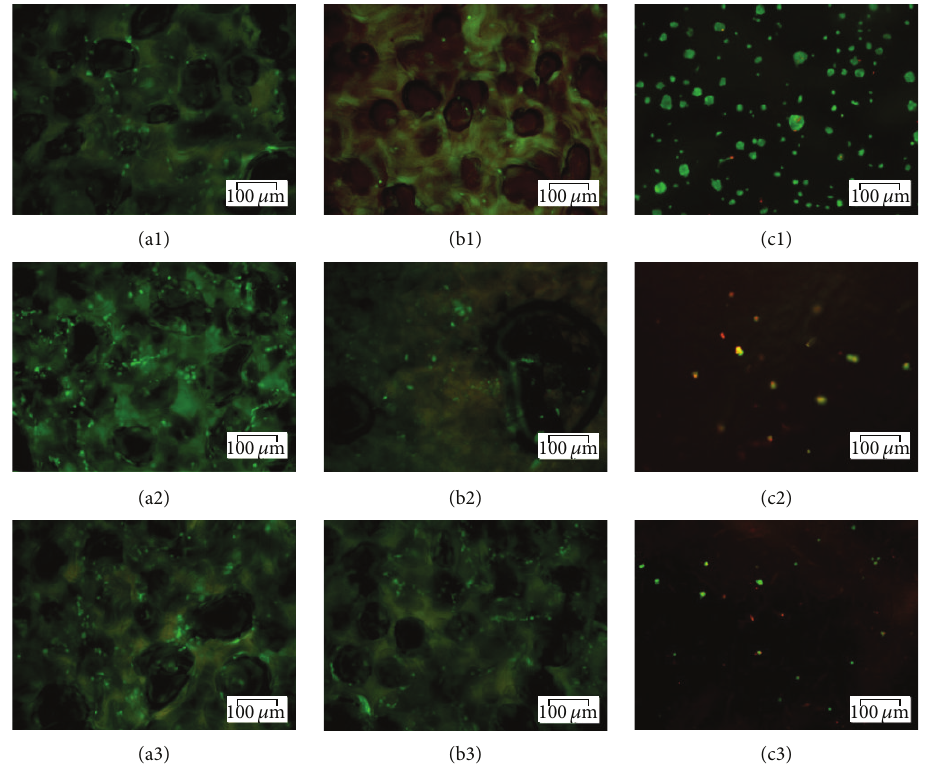
Figure 4: Fluorescence microscopy micrographs revealing live and dead cells in G-A-PAA (a), G-A (b), and PAA (c) matrices at 24 h (1), 5 days (2), and 7 days (3) of culture.